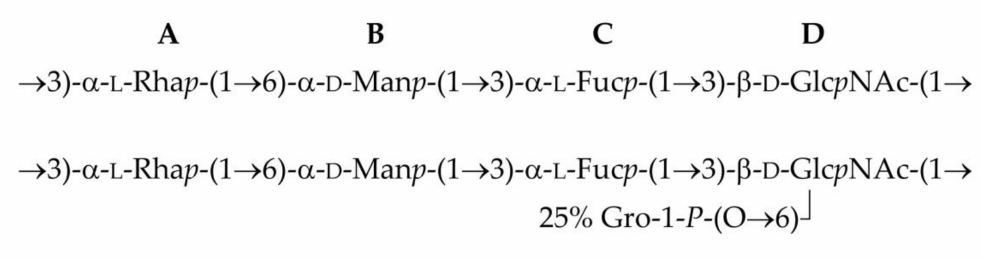
Figure 4. Structure of the O-polysaccharide of P. agglomerans 8488 (top) and revised structure of the O-polysaccharide of P. agglomerans 7969